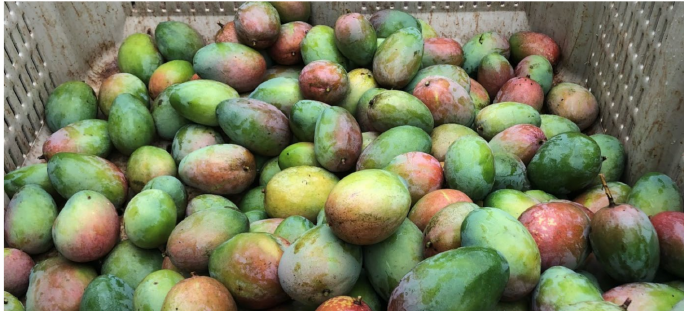
Figure 6. Mango “Keitt” harvest.